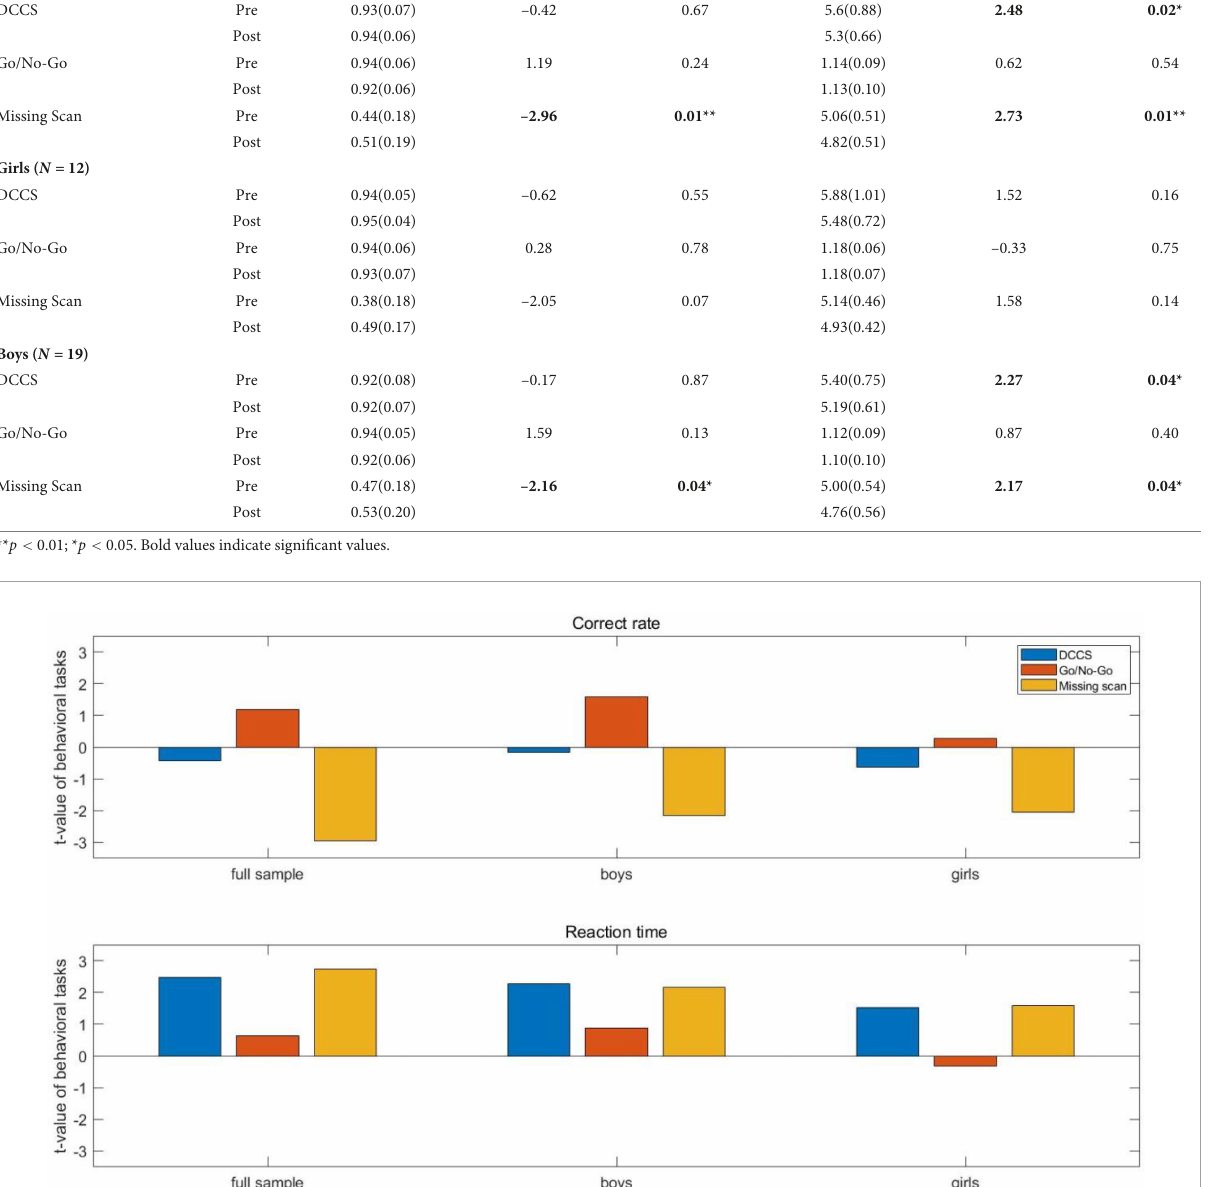
set by the same name. Each time four animals appeared on the screen for 10 s, then disappeared into a “house” for 3 s, and then three animals re-appeared on the screen. Children were then instructed to call the name of the missing animal in 6 s before the next set of animals appeared on the screen. Each test